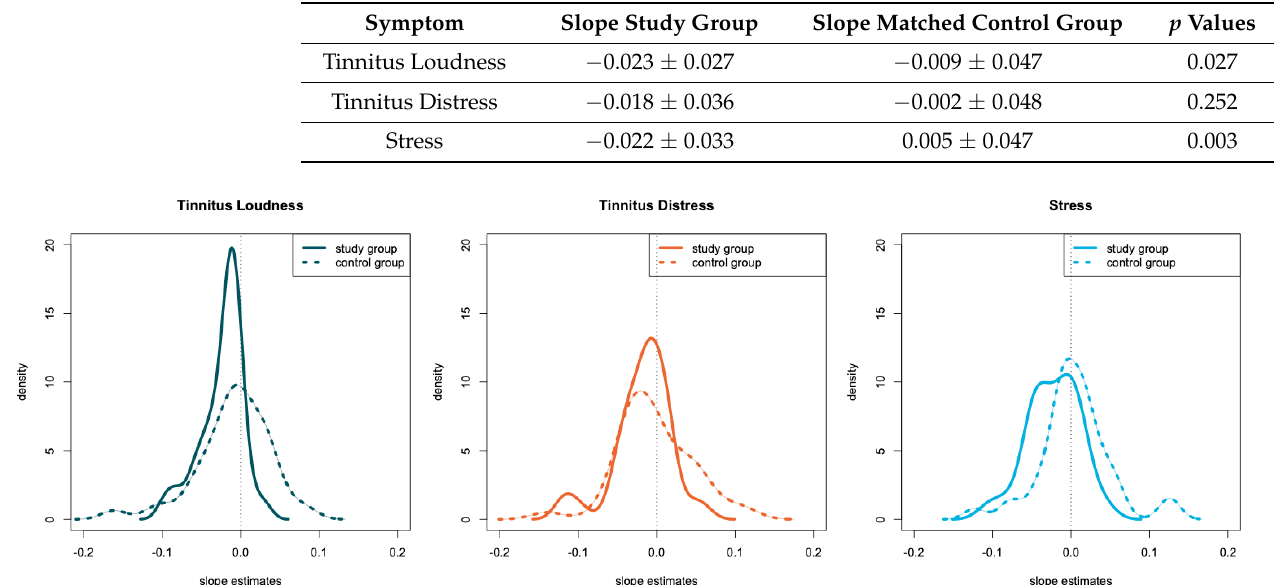
Table 6. Comparison of regression estimates of the study group compared to the matched control group. p values are based on the Wilcoxon rank-sum test, which was calculated to compare the distributions of estimates. Symptom